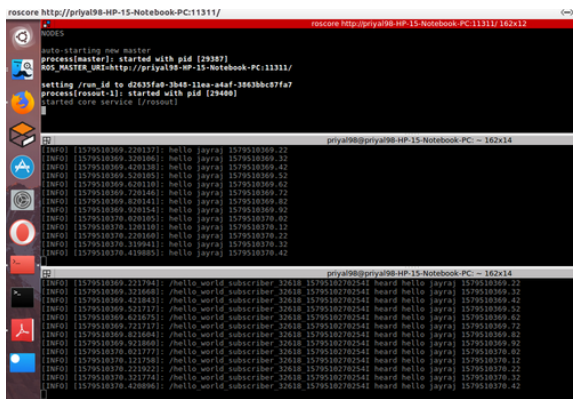
Figure 2. Basic ROS Program.